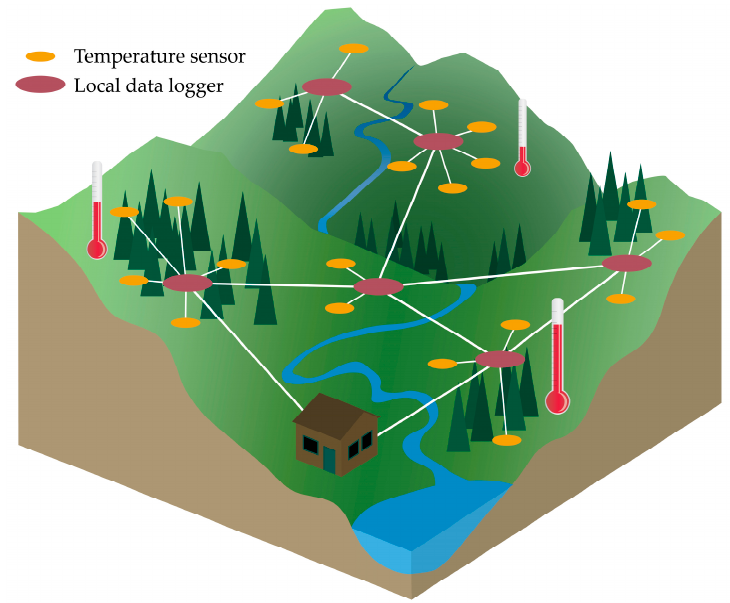
Figure 14. Wireless sensors in a mesh network in which individual units (the temperature sensors) transmit data to local nodes (the data loggers), which in turn transfer data to a station that is connected to outside resources via the Internet. Whereas positioning devices discussed in the early sections of this paper primarily detect the movements of people, equipment, or other resources, wireless sensor networks (WSNs) are used broadly in forest research and in environmental fields to monitor air masses, soil moisture, and other environmental factors